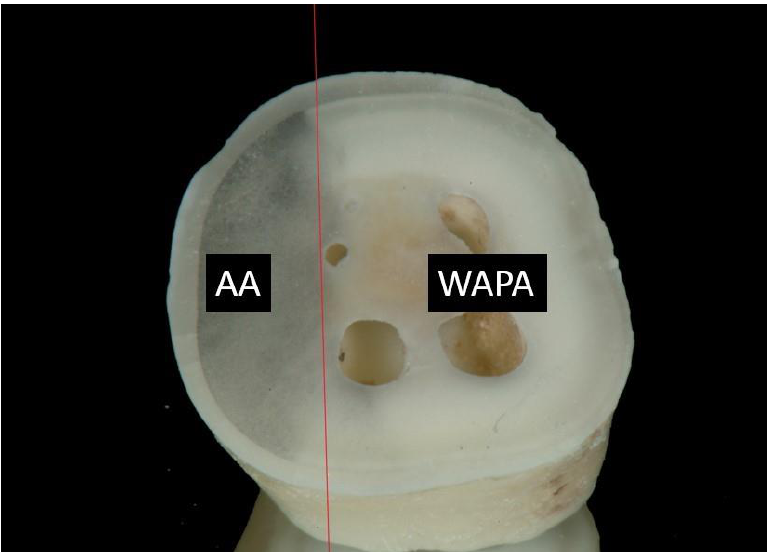
Figure 1. Image of a tooth surface treated with air abrasion ( AA ) and water–air-particle abrasion ( WAPA ). The red line delineates the boundary between the two treatments. AA shows the effects of black pigmentation of the dentin, while WAPA does not.